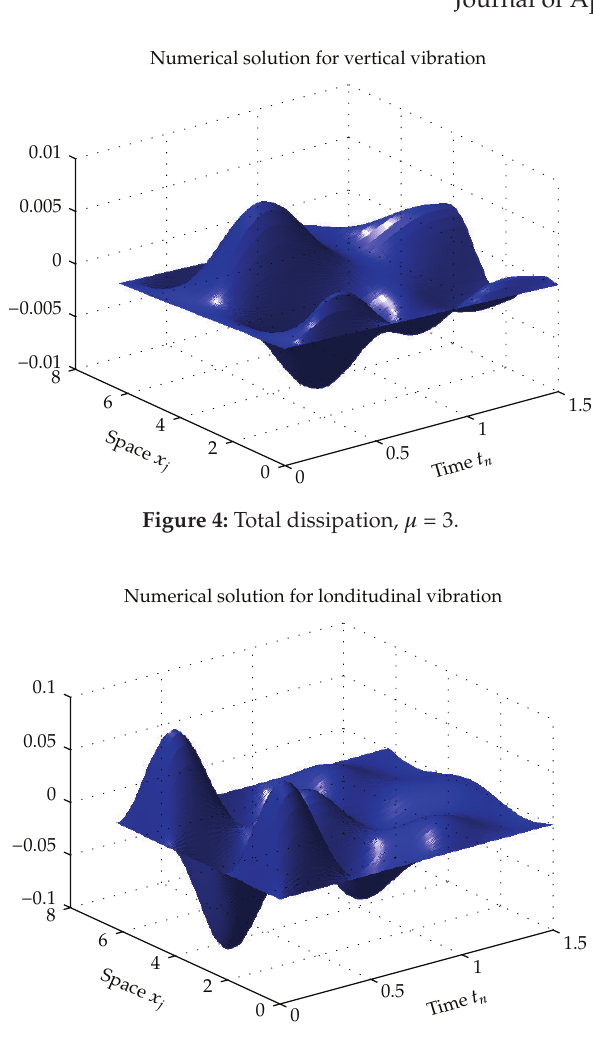
Figure 5: Total dissipation, μ (cid:8)